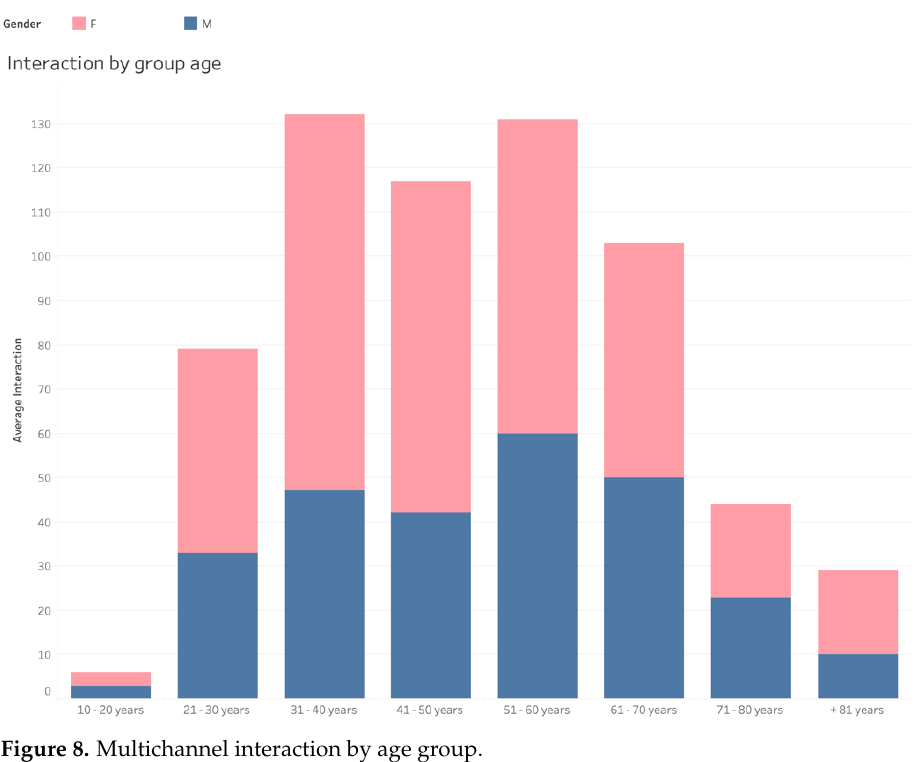
Figure 8. Multichannel interaction by age group.